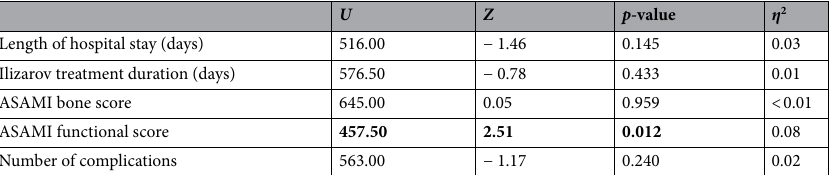
Table 3. Mann–Whitney U test results for selected quantitative variables, stratified by the surgical technique (open vs. closed) (N = 75). U and Z Mann–Whitney U test statistics, p-value level of significance, η2 (eta- squared) a measure of effect size for Mann–Whitney U